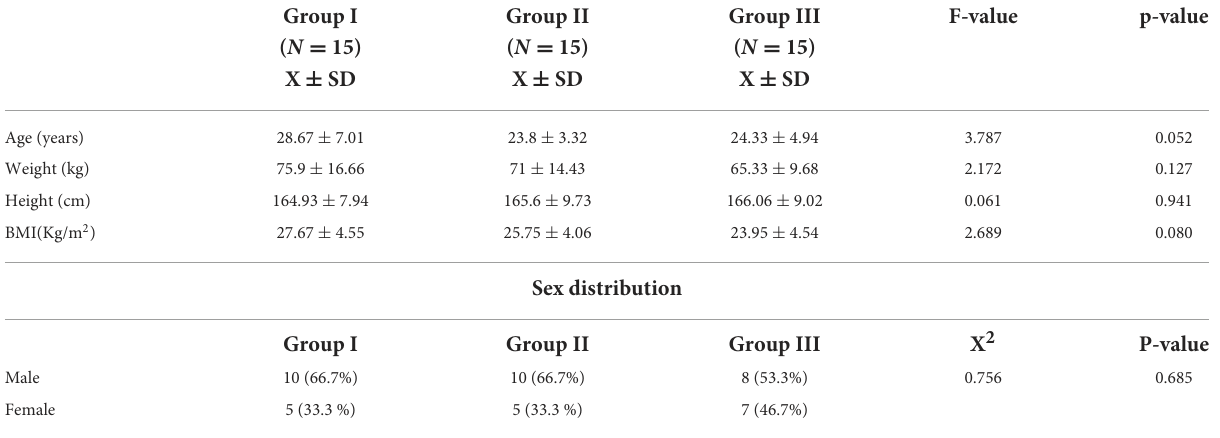
TABLE 1 Mean (SD) and one-way ANOVA for the participants’ demographic data.